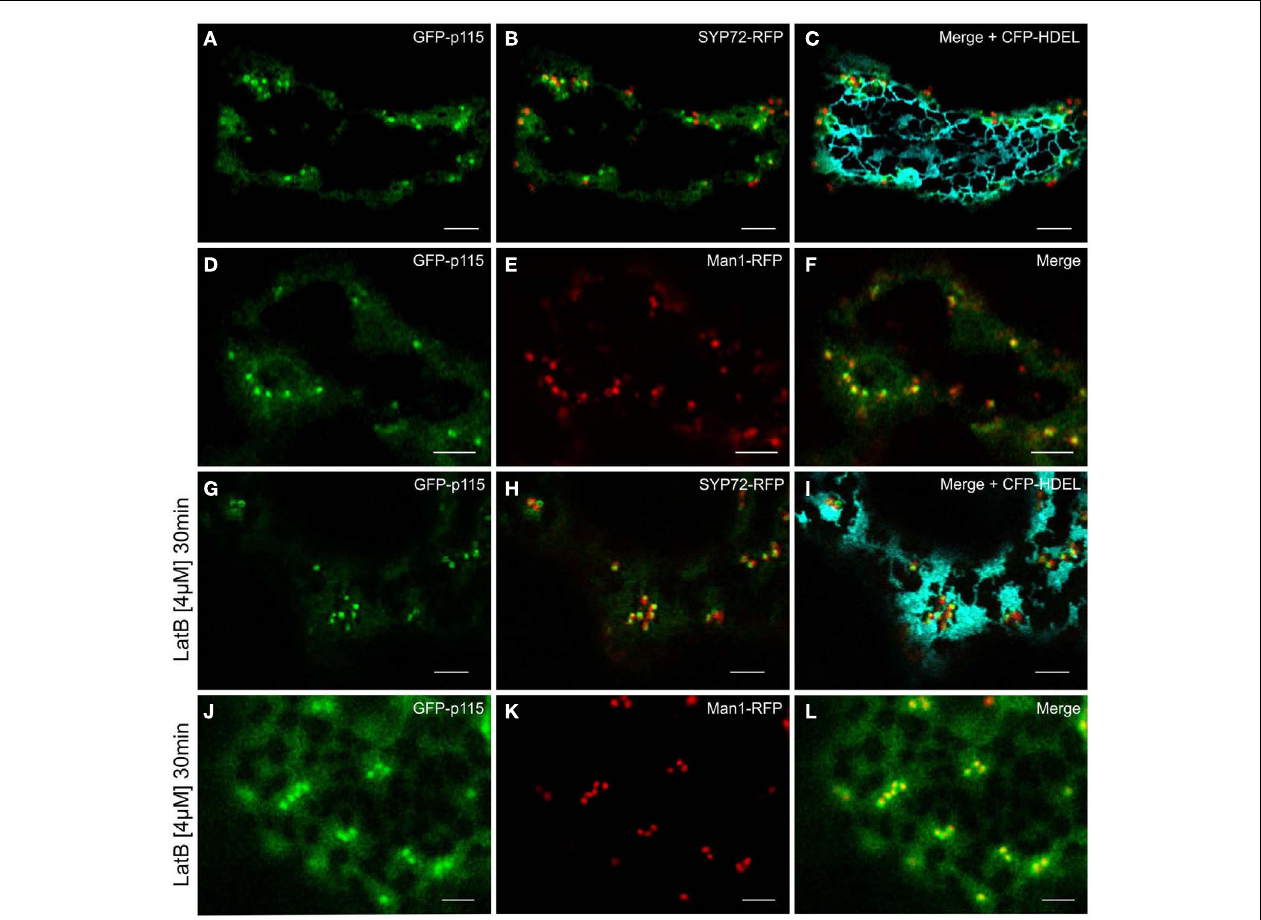
degree of colocalization was detected between GFP-p115 and Man1-RFP before (D–F) and after latrunculin B treatment (J–L) . Magnification bars = 5 µ